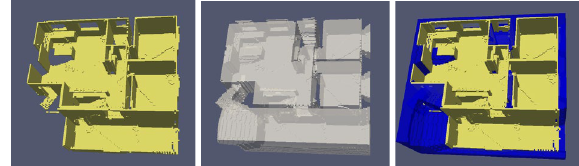
Fig. 5. Reconstructed voxel model with three classes. Left: hard , centre: transparent , right: hard + unknown After this, the transparent space is considered navigable (preventing routes through windows remains the operator’s responsibility: close curtains to avoid confusion). This as opposed to more traditional approaches, where the point cloud